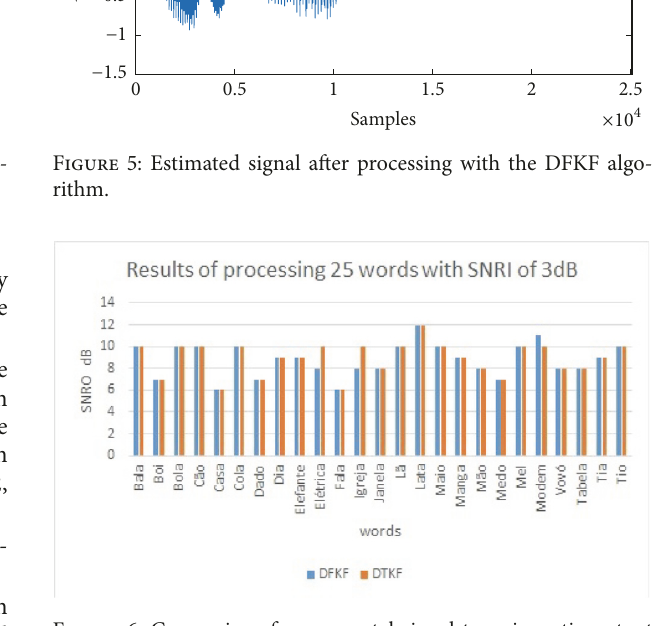
Figure 6: Comparison for segmental signal-to-noise ratio output (SNRO) with 25 words contaminated by white noise with signal-to- noise ratio input (SNRI) of